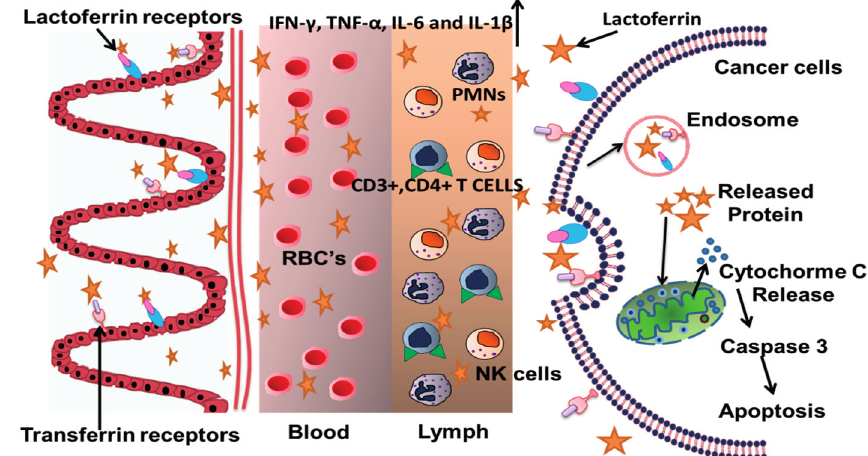
Figure 3. Role of lactoferrin in the activation of immune cells. Lactoferrin enters in the intestinal microvilli through the help of lactoferrin receptors and transferrin receptors